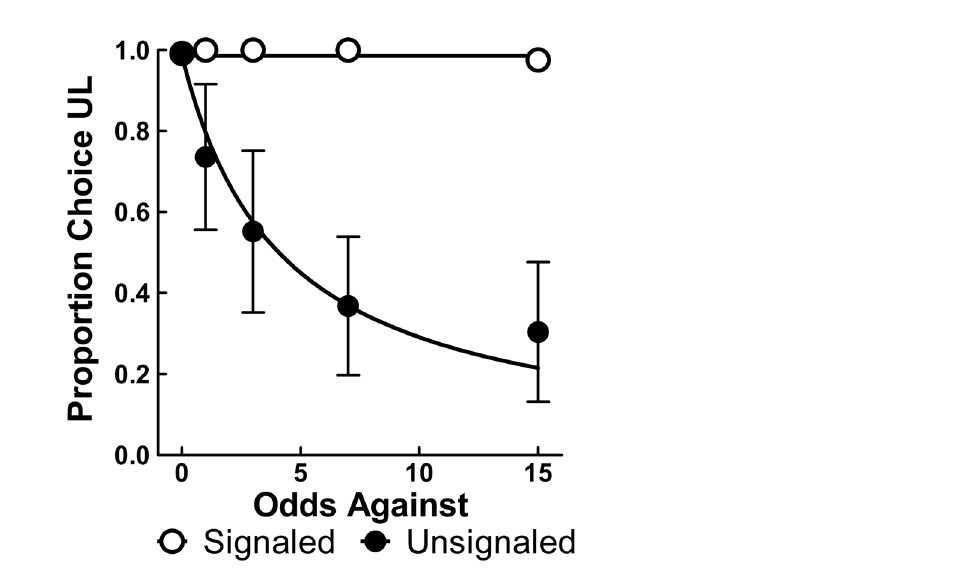
Figure 2. Mean ( ± SEM) proportion choice of the UL alternative averaged over the last five sessions of baseline training ( n = 10). Slope parameter estimates ( h ) from Equation 1 were 0.24 for the Unsignaled group and < 0.01 for the Signaled